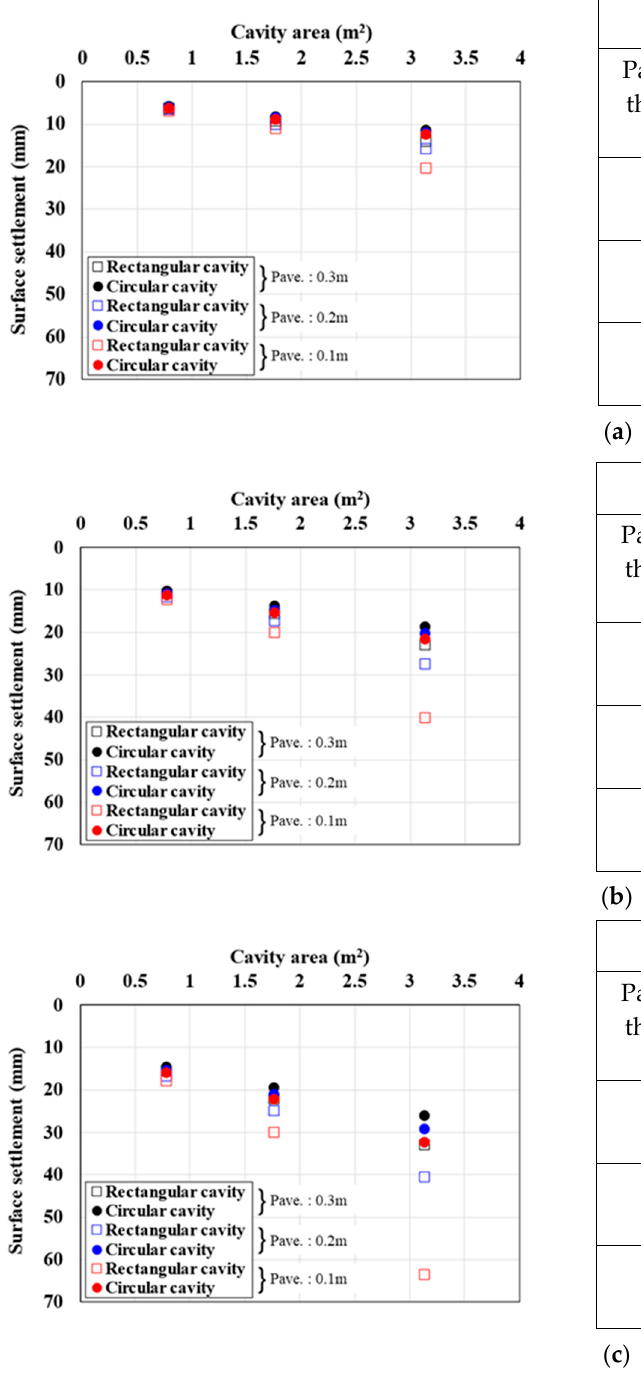
Figure 9. Surface settlement according to cavity area by pavement thickness (pavement elastic modulus: 500 MPa). Traffic load: ( a ) 12.7, ( b ) 25.4, and ( c ) 38.1 kN/m 2 .